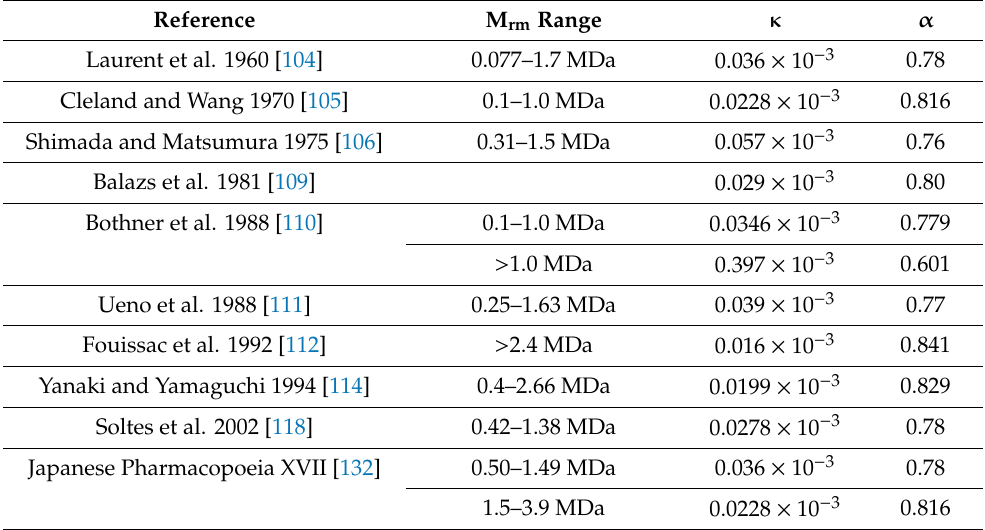
Table 1. Published constants in the Mark–Houwink equation for HA [ η ] in units m 3 / kg).